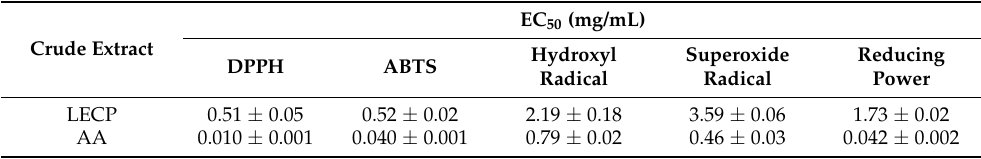
Table 3. Antiradical activity of L. edodes extract and